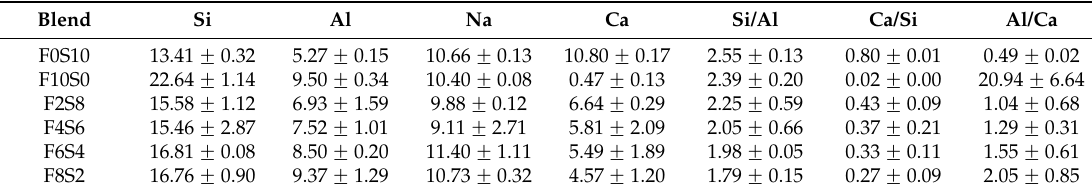
Table 3. The average content of the main elements (at %) and their ratios in the matrix of alkali-activated